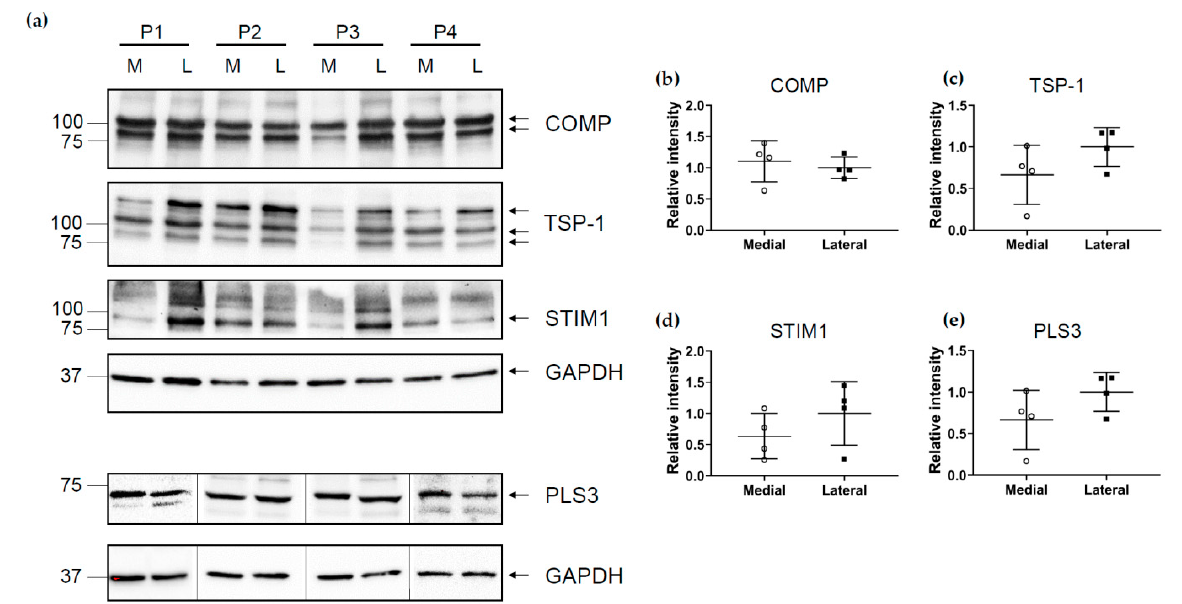
Figure 7. Immunoblots of cartilage extracts from the medial and lateral tibial compartments (M = medial, L = lateral) of four patients (P1–4: patient 1–4). ( a ) Blots were developed with specific antibodies directed against COMP, TSP-1, STIM1 and PLS3. Densitometric quantification of the bands was performed using ImageJ. The mean value of the band intensity in the lateral sample was set as 1 and all other intensities were related to this value. Band intensities for all proteins analyzed were normalized to intensities of GAPDH bands in the same samples run on the same gel. Relative intensities are shown for ( b ) COMP ( c ) TSP-1, ( d ) STIM1 and ( e ) PLS3. Significance between medial and lateral tibial plateaus was evaluated using the nonparametric Wilcoxon test.